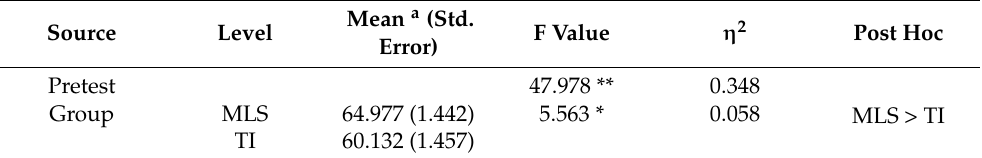
Table 4. ANCOVA summary table of the pretest and posttest scores of mathematics learning interest scale.